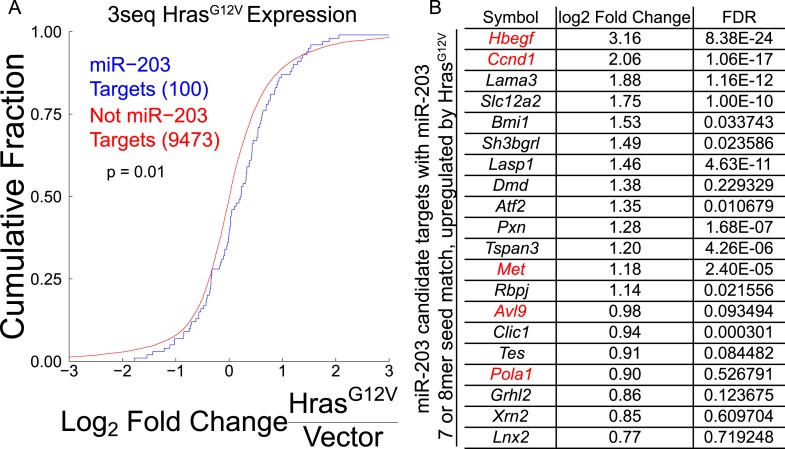
A subset of miR-203 targets are upregulated by HrasG12V.(A) miR-203 target genes identified through meta-analysis containing miR-203 seed matches are more likely to be upregulated upon HrasG12V expression in primary keratinocytes than non-targeted transcripts (p-value ≤0.05, K–S test one-sided). (B) Top 20 miR-203 targets, based on expression meta-analysis, ranked by upregulation by HrasG12V, genes shown in red are also identified by Ago2-HITS-CLIP.